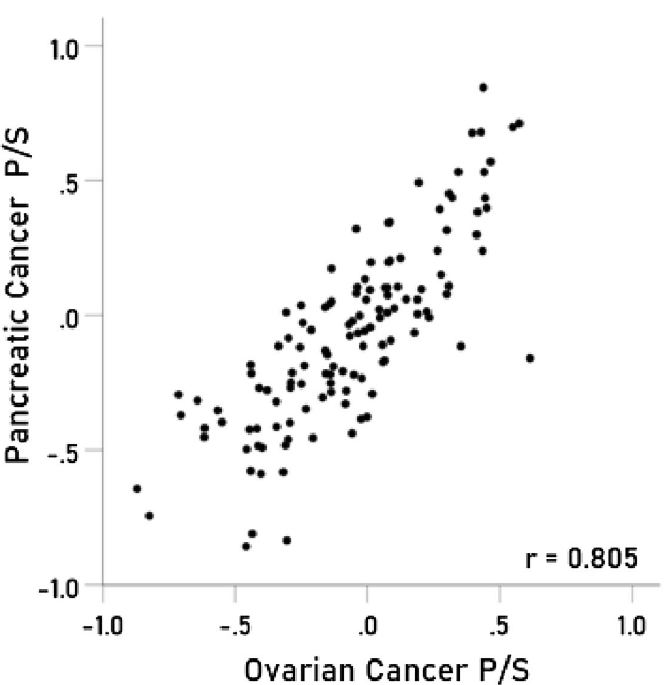
Figure 3. Immunogenetic P/S estimates for pancreatic cancer are plotted against those for ovarian cancer. P < 0.001; N =